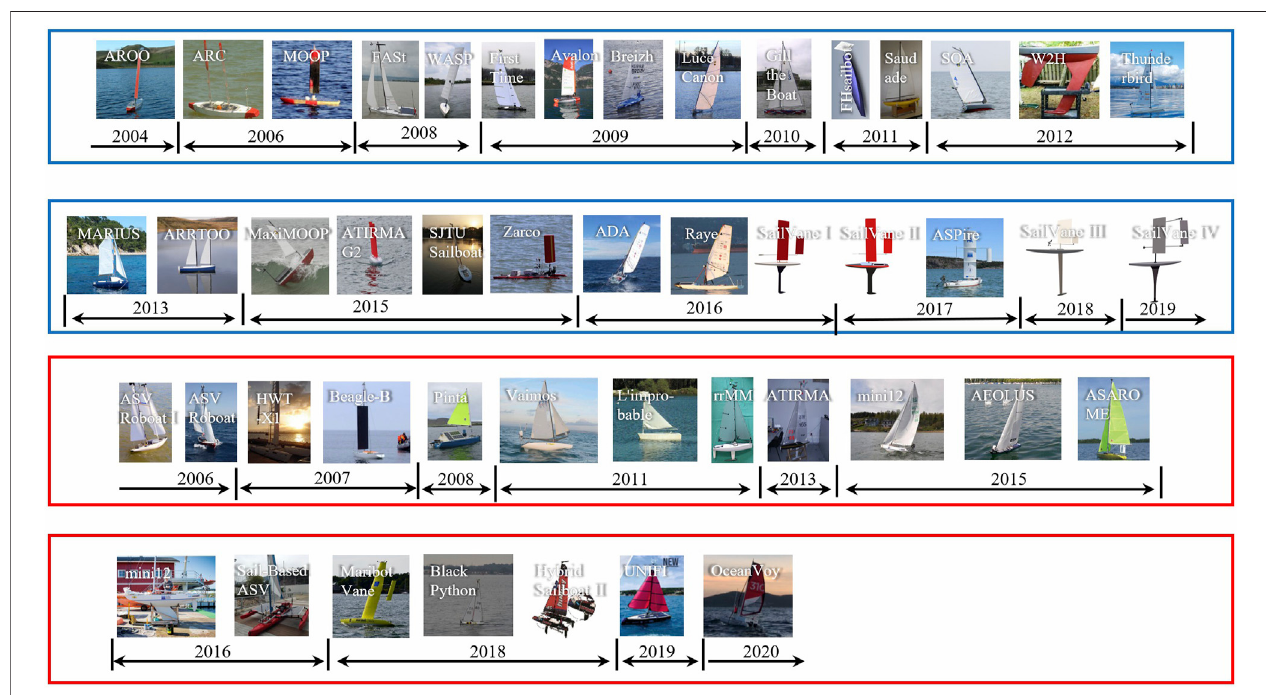
FIGURE 5 | Two groups of developed sailboats: designing by researchers (in blue boxes) and retro fi tting based on retailing sailboats (in red boxes).